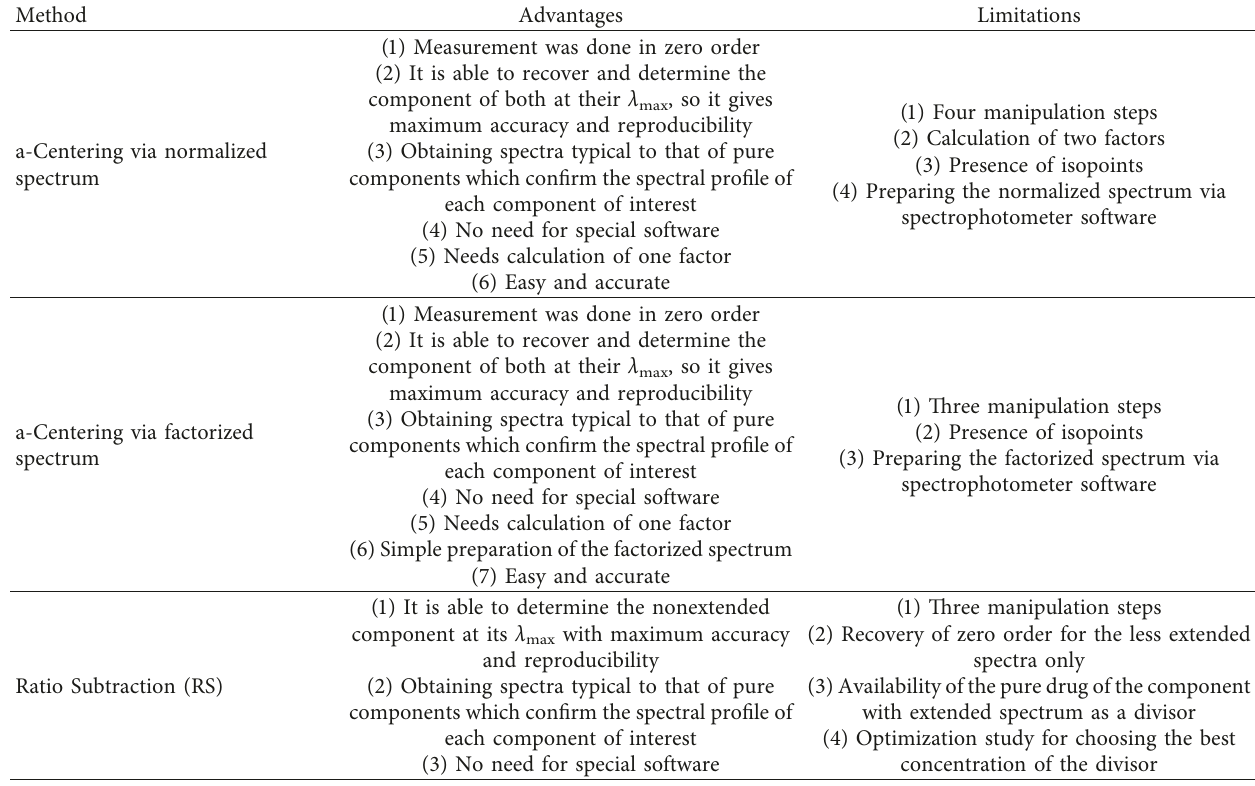
Table 6: Advantages and limitations of each fingerprint method used for the analysis of co-formulated otic solution of ciprofloxacin and fluocinolone acetonide in their challengeable